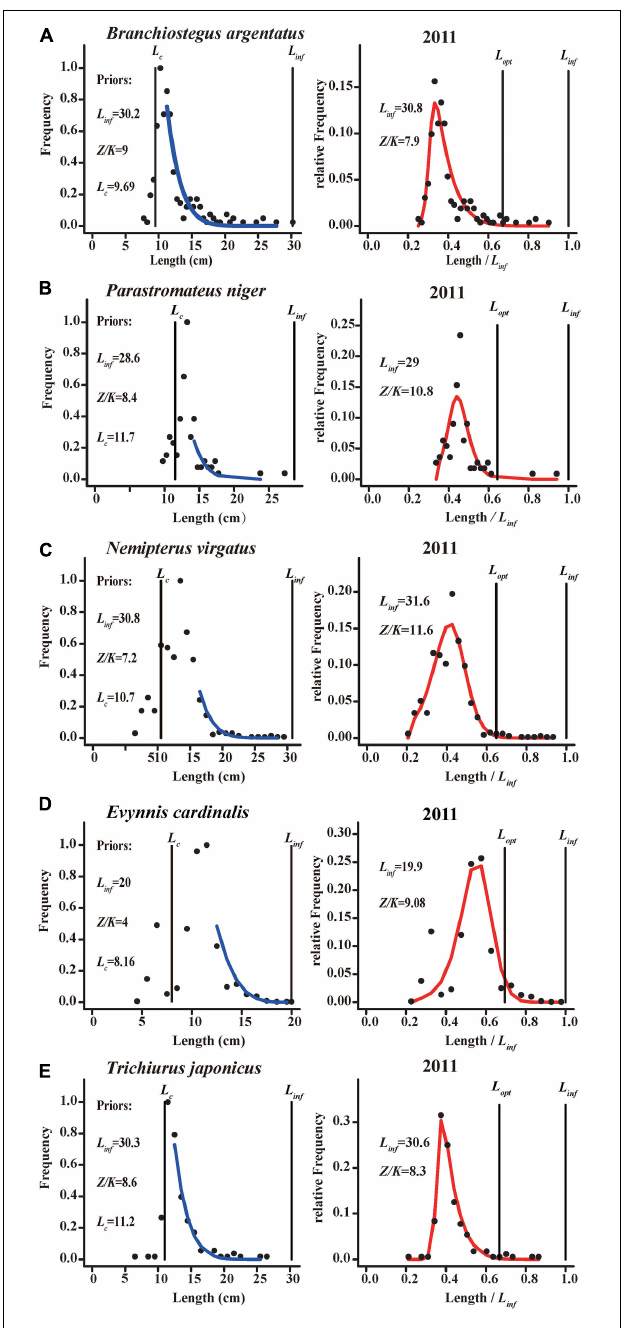
FIGURE 2 | The assessment results of five “collapsed” species with length-based Bayesian biomass (LBB) method in Beibu Gulf. The blue line (left) represents the fit of the data and the LBB estimation, and the red line (right) is the evaluation from the LBB method of stock resources. (A–E) Presents the result of Branchiostegus argentatus , Parastromateus niger , Nemipterus virgatus , Evynnis cardinalis , and Trichiurus japonicus , respectively.